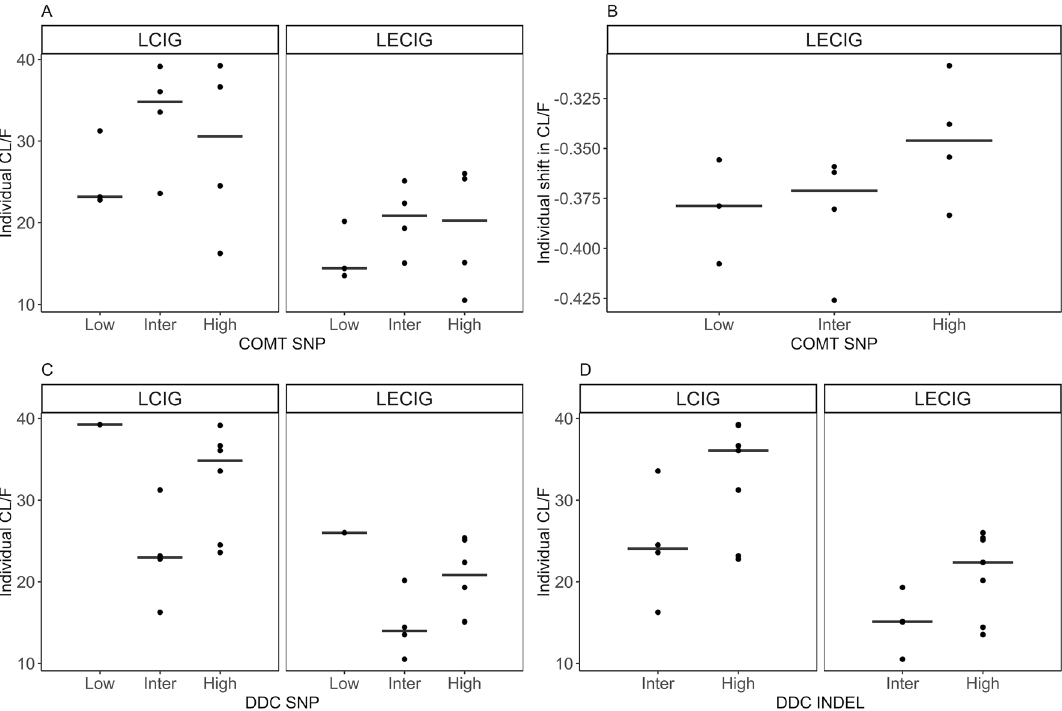
Figure 3. Graphical analysis of genotype results and individual estimated LD CL/F, with LCIG and LECIG treatment. COMT (rs4680, top left, A) and individual shift CL/F (top right, B), DDC SNP (rs321451, bottom left, C), DDC INSDEL (rs3837091, bottom right, D). The middle line represents the median of the